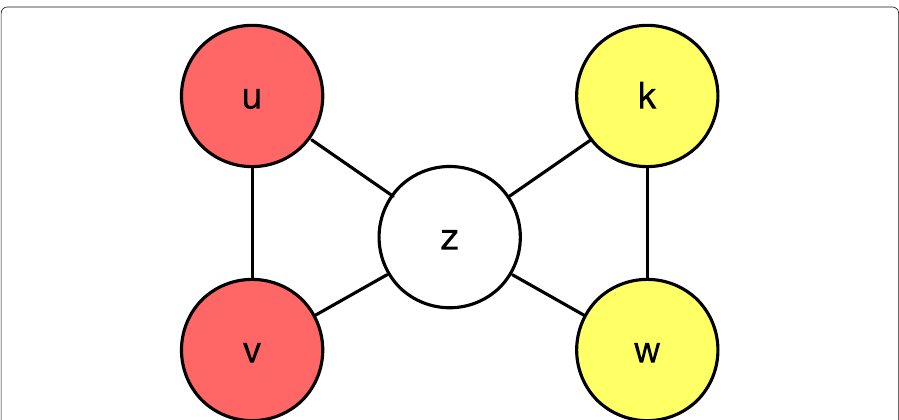
Fig. 1 Label Propagation. In the example, the node z represents the center of a bow-tie structure since it has its neighbors divide equally among two different communities ({ u , v } belonging the red one, { k , w } to the yellow one). In such scenario the classic LP formulation will assign z to only one of the two communities after experiencing a ping-pong effect: this will cause nondeterminism. Our approach instead will assign z to both partitions producing a soft, but stable, community